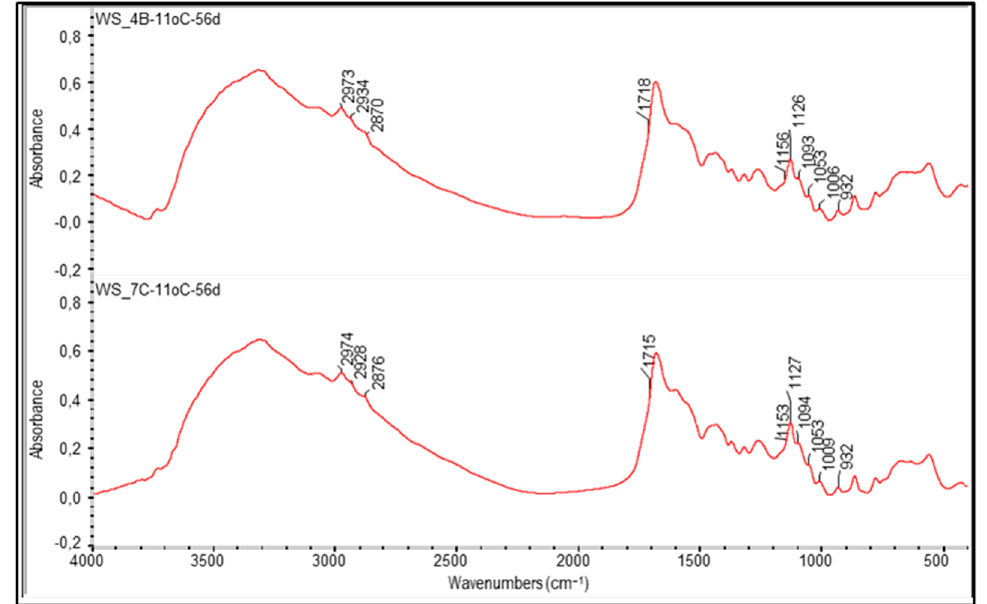
Figure 2. Fourier-transform infrared spectra in 4000–400 cm − 1 spectral region of B (4B-11 °C-56d) and C (7C-11 °C-56d) cheese water-soluble extracts; B, reduced-fat sheep milk cheese; C, reduced-fat sheep milk cheese fortified with sweet sheep buttermilk. Table 2. Wavenumbers of the 10 peaks distinguished in 3012–2851, 1854–1611 and 1192–909 cm − 1 spectral regions of cheese water-soluble extracts could be attributed to the functional groups of phospholipids, among others.